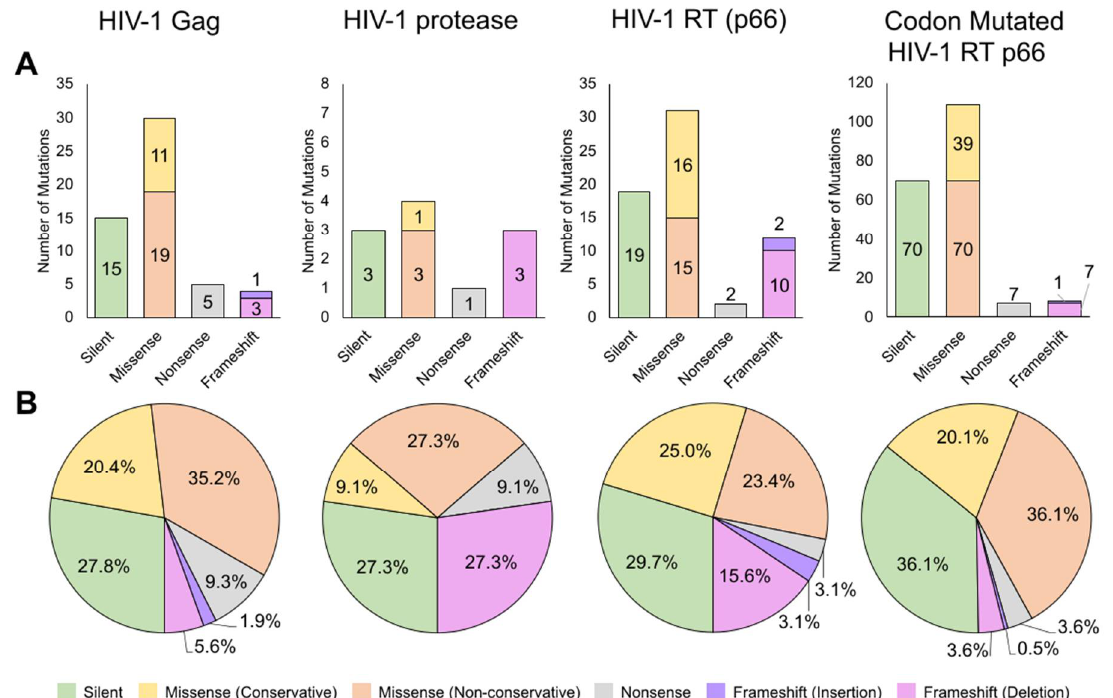
Figure 3. Generated amino acid mutations using HIV-1 RT. ( A ) Bar chart of amino acid mutations observed in HIV-1 Gag ( n = 54), protease ( n = 11), RT p66 ( n = 64), and codon mutated RT p66 ( n = 194). ( B ) Pie chart of the relative amino acid mutation frequencies (expressed as a percentage). For the codon mutated RT p66, two variants (20 and 80 a, b) containing deletions without frameshifts are not shown. Silent, missense (conservative), missense (non-conservative), nonsense, frameshift (insertion), and frameshift (deletion) mutations are shown in green, yellow, orange, gray, purple, and pink, respectively.